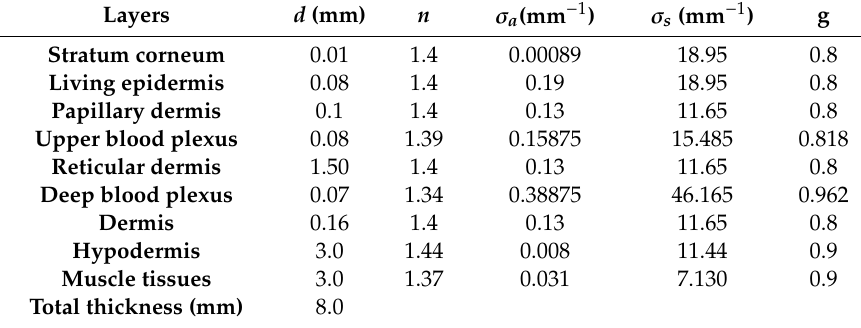
Table 2. Thickness, absorption coe ffi cient, scattering coe ffi cient and anisotropic factor of a skin model at 785 nm